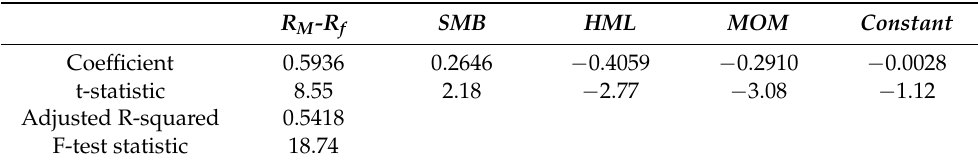
Table 1. Summary statistics for equal weight